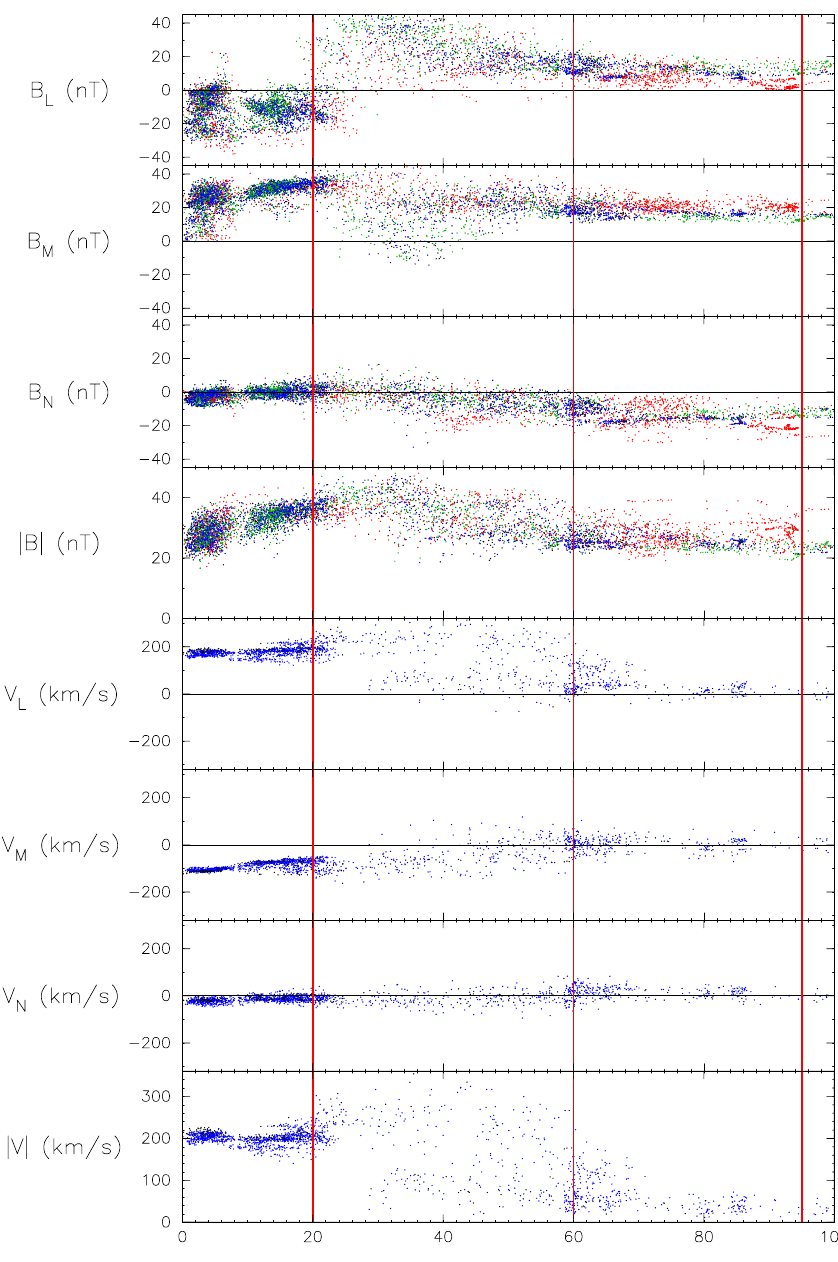
Fig. 6. The magnetic field and proton velocity data shown in Fig. 5, rotated into boundary normal